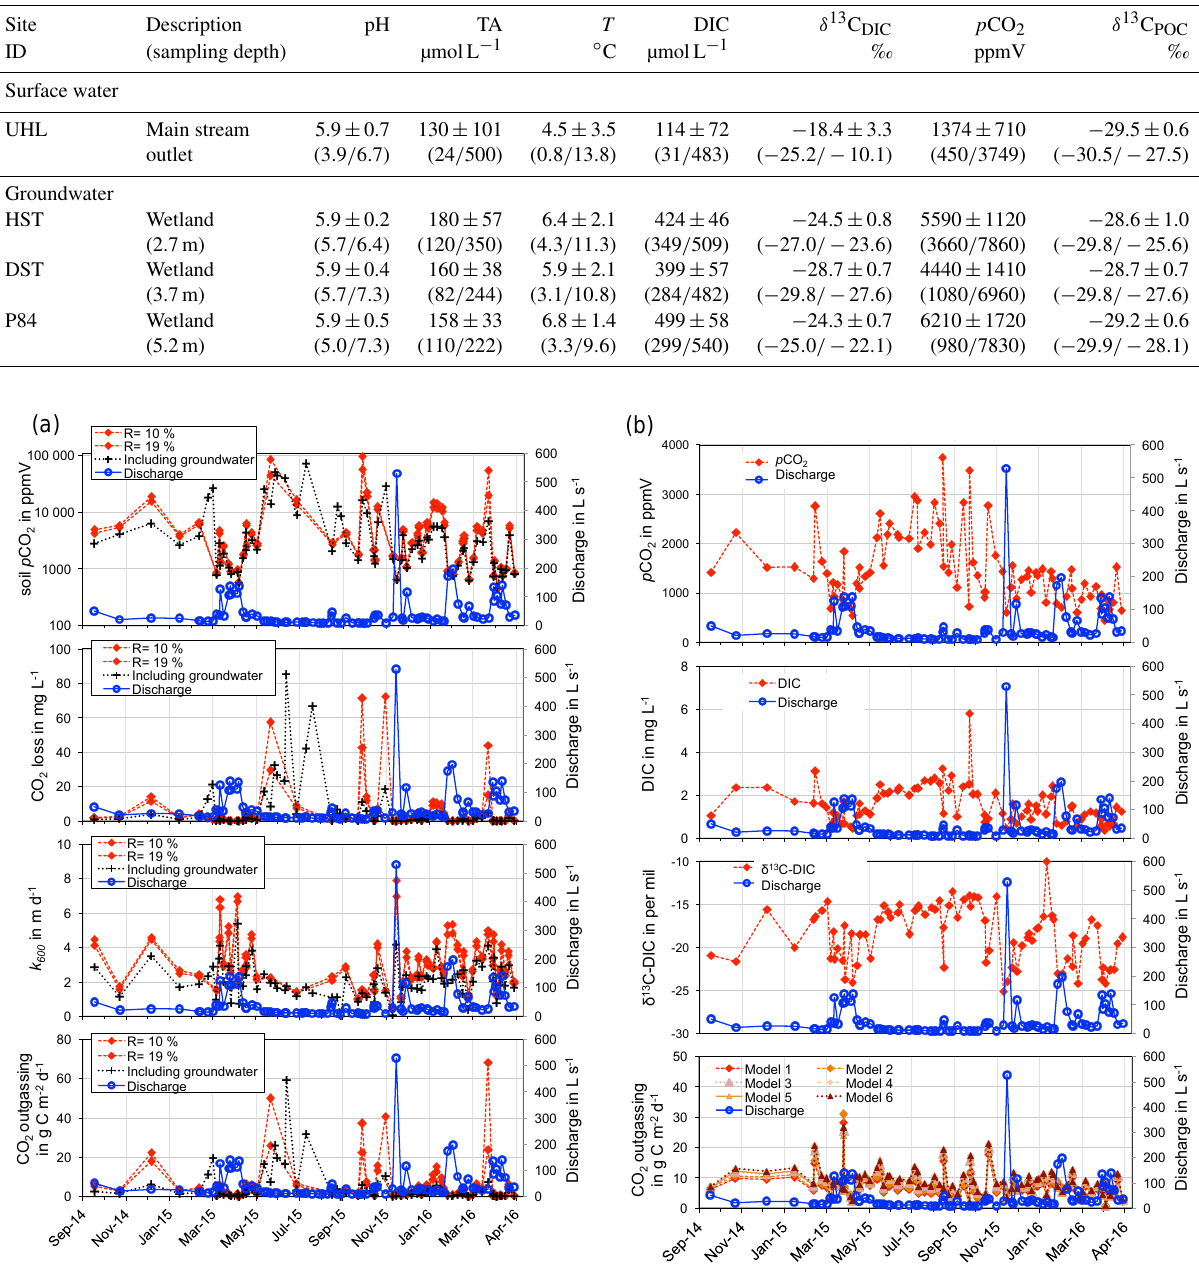
Figure 2. Data of measured discharge, in situ p CO 2 , δ 13 C DIC , DIC concentrations, and CO 2 fluxes calculated via model equations in Raymond et al. (2012) for the Uhlí ˇ rská catchment outlet (UHL) (a) and modelled soil p CO 2 and CO 2 loss, as well as k 600 calculated from model results and CO 2 outgassing normalised to the stream surface area (b)